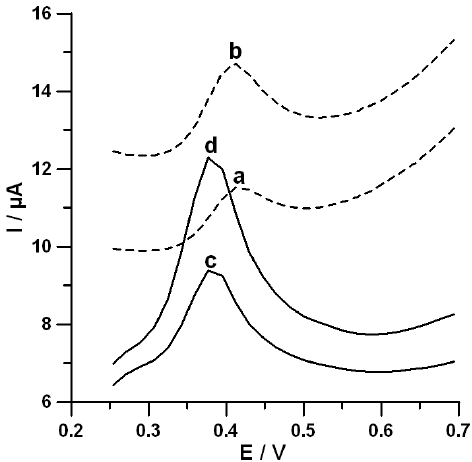
Figure 1. Differential-pulse adsorptive stripping voltammetric (DPAdSV) curves of diclofenac (DF) with different concentrations in a 0.1 mol L −1 NaAc–HAc solution with a pH value of 5.0 ± 0.1 at the surface of a bare screen-printed carbon electrode (SPCE) (a,b) and the surface of a screen-printed carbon electrode modified with multiwalled carbon nanotubes (SPCE/MWCNTs-COOH) (c,d). (a) and (c) are for the DF concentration of 0.05 µmol L −1 . (b) and (d) are for the DF concentration of 0.1 µmol L −1 . The DPAdSV parameters: accumulation potential ( E acc ) of −0.5 V, accumulation time ( t acc ) of 30 s, amplitude (A ) of 100 mV, modulation time ( t m ) of 40 ms, and scan rate ( ν ) of 175 mV s − 1